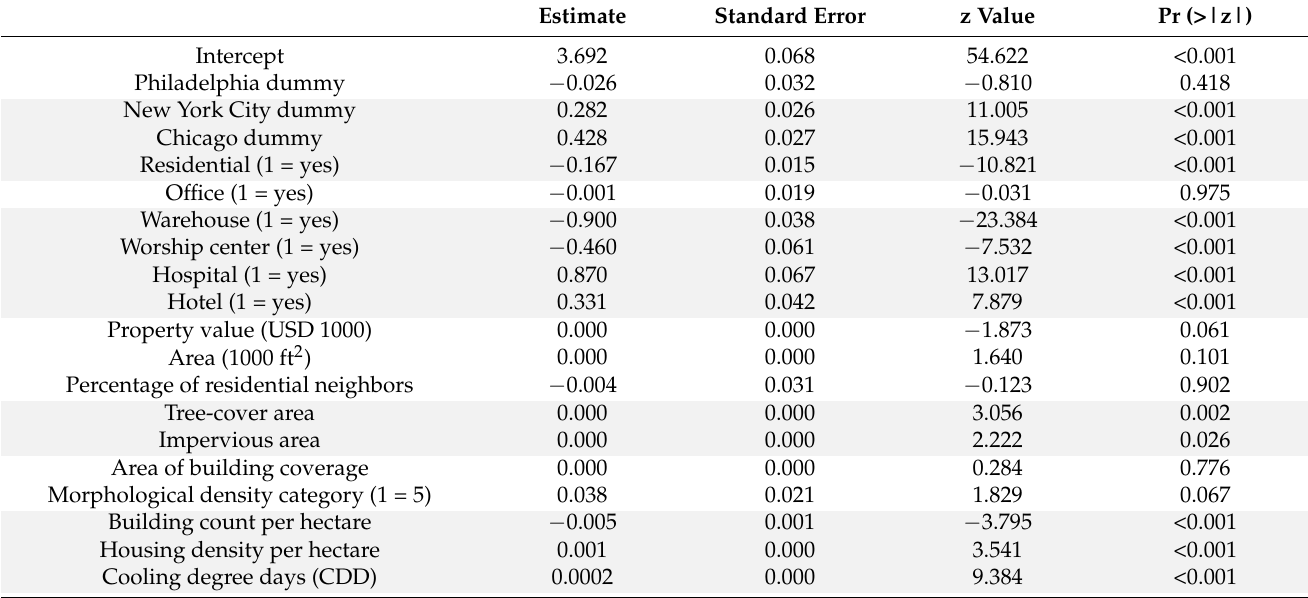
Table 5. Spatial regression results for cities